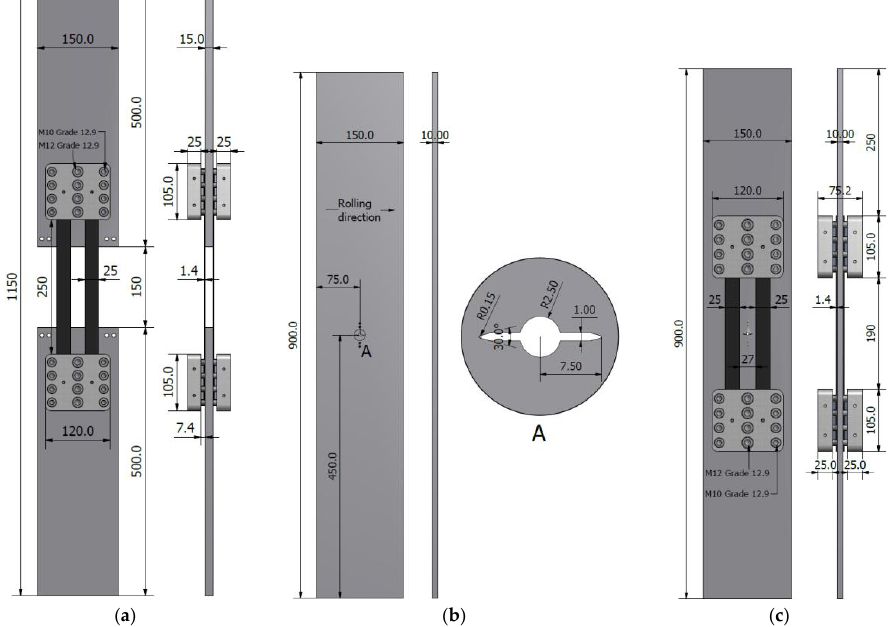
Figure 4. Specimen dimensions (all dimensions are in mm): ( a ) clamp test specimen; ( b ) reference specimen and electrical discharge machine (EDM) notch details; and, ( c ) prestressed unbonded reinforcement (PUR) specimen.